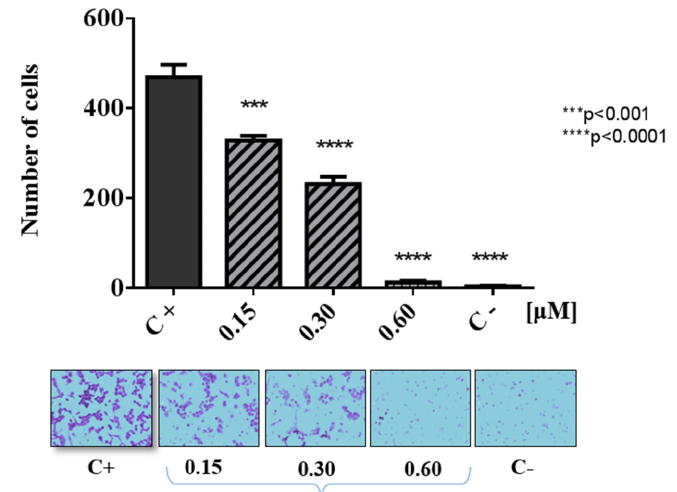
Figure 3. Effects of complex 3 on MDA-MB-231 cell migration in Boyden chambers. Up: Graph of number of cells. Down: The positive control (C+) represents migrating cells without any treatment and the negative control (C − ) was cells migrating toward an FBS-free